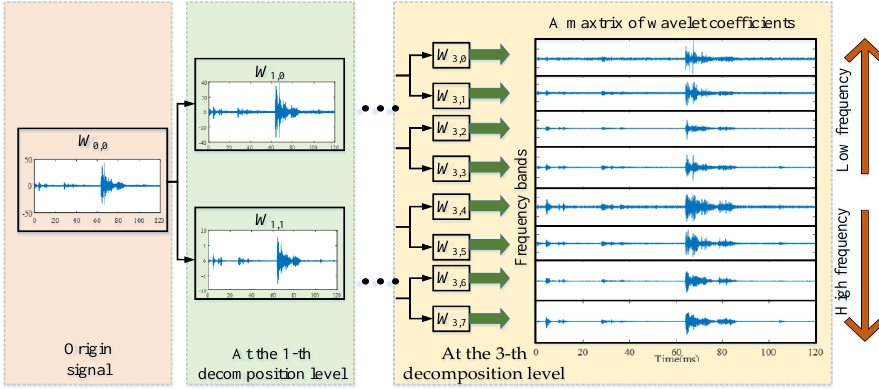
Figure 3. Schematic diagram of wavelet packet time-frequency analysis of vibration signal.